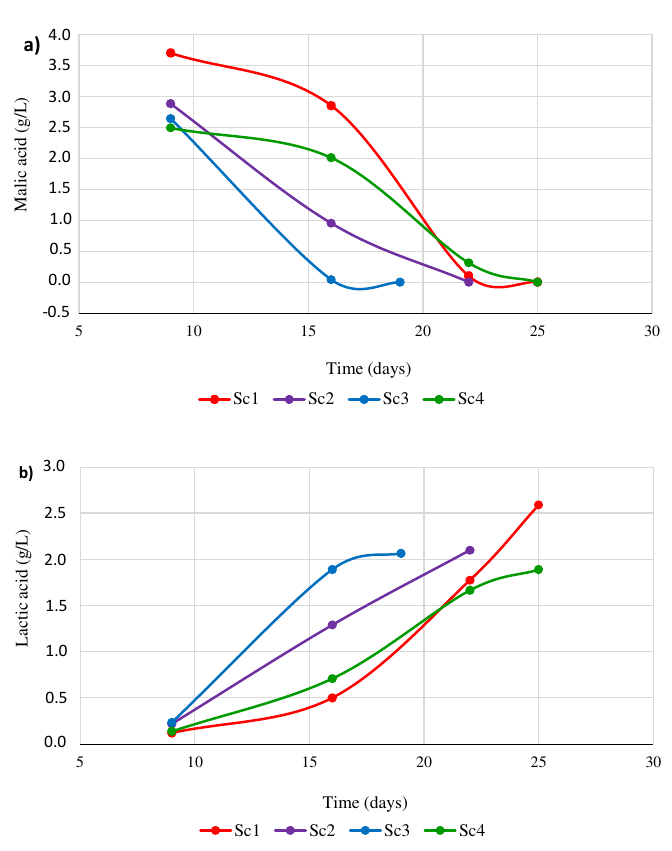
Figure 2. Evolution of ( a ) malic acid (g/L) and ( b ) lactic acid (g/L) during the malolactic fermentation for the four vinifications carried out with the different yeasts (Sc1, Sc2, Sc3, and Sc4). The contents of both acids are given as average values (n = 2).